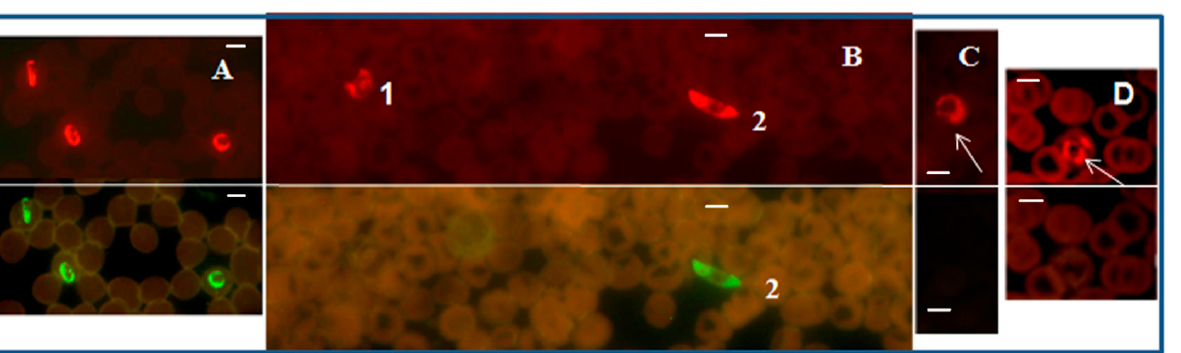
Figure 1. Plasmodium genus-specific FISH test identifying all human malaria parasites. Photographs showing Plasmodium genus-specific FISH test results with blood smears from patients with con- firmed P. falciparum, P. vivax, P. malariae, P. ovale and P. knowlesi infections. Fluorescence was viewed